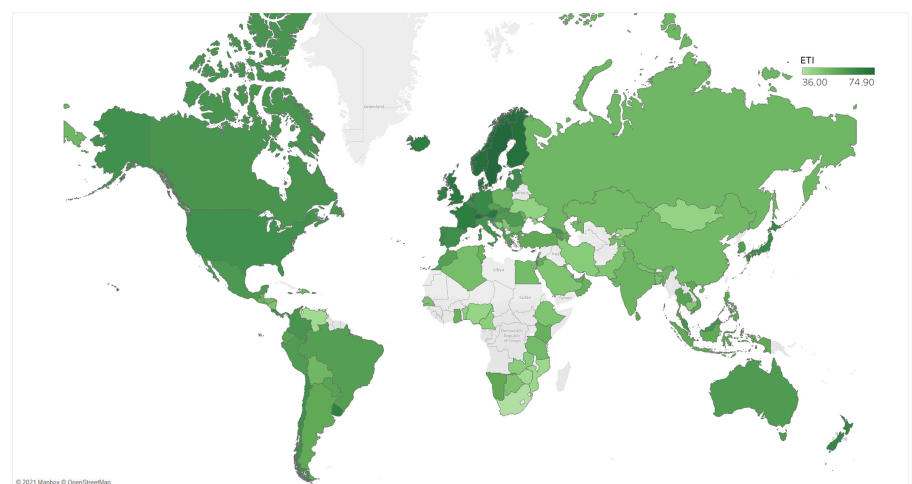
Figure 5. Distribution of original Energy Transition Index values.